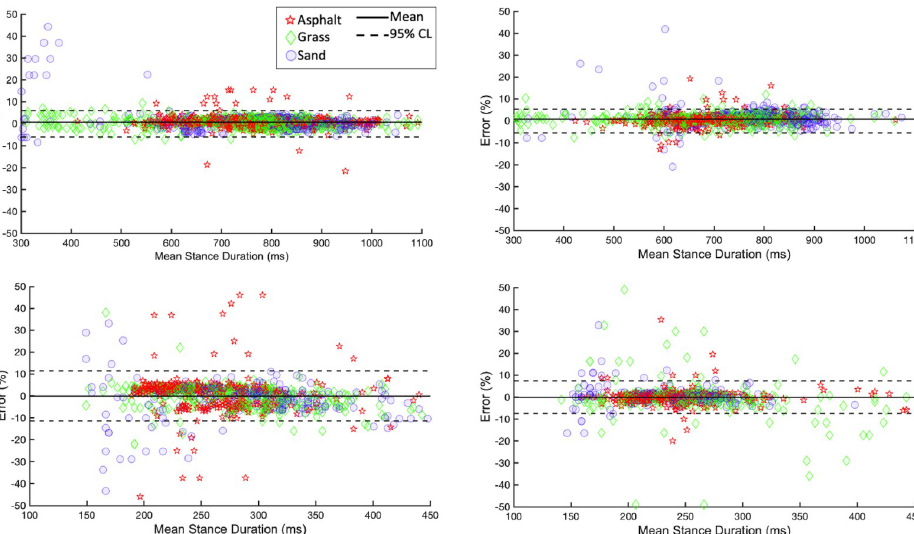
Fig 6. Bland-Altman plots of novel methods compared to reference method to calculate stance duration on each surface. The difference between stance durations calculated using reference method and best novel method for each event (shown as a percentage of stride duration) as a function of the mean of the two. Stance durations from control surface are shown as red stars, from grass as green diamonds and from sand as blue circles. The solid horizontal lines (-) indicate the mean error and dashed horizontal lines (- -) the ULoA and